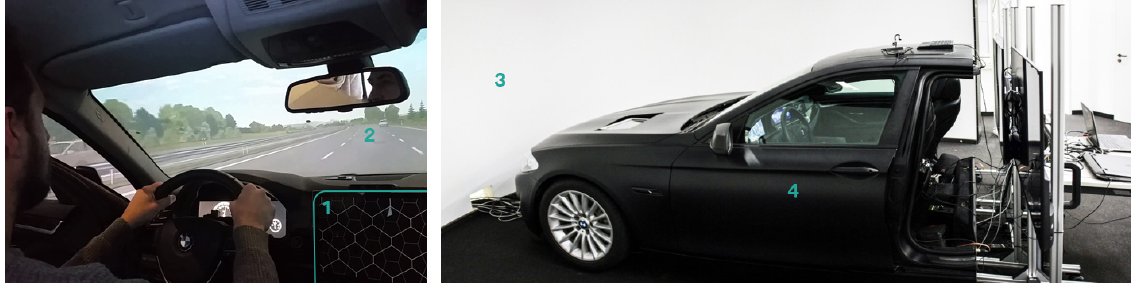
Figure 3. Concepts were presented on a tablet in the center stack (1) while subjects had to follow a virtual car (2). The driving simulation was projected onto a curved 180° screen (3) and controlled from within a car mockup